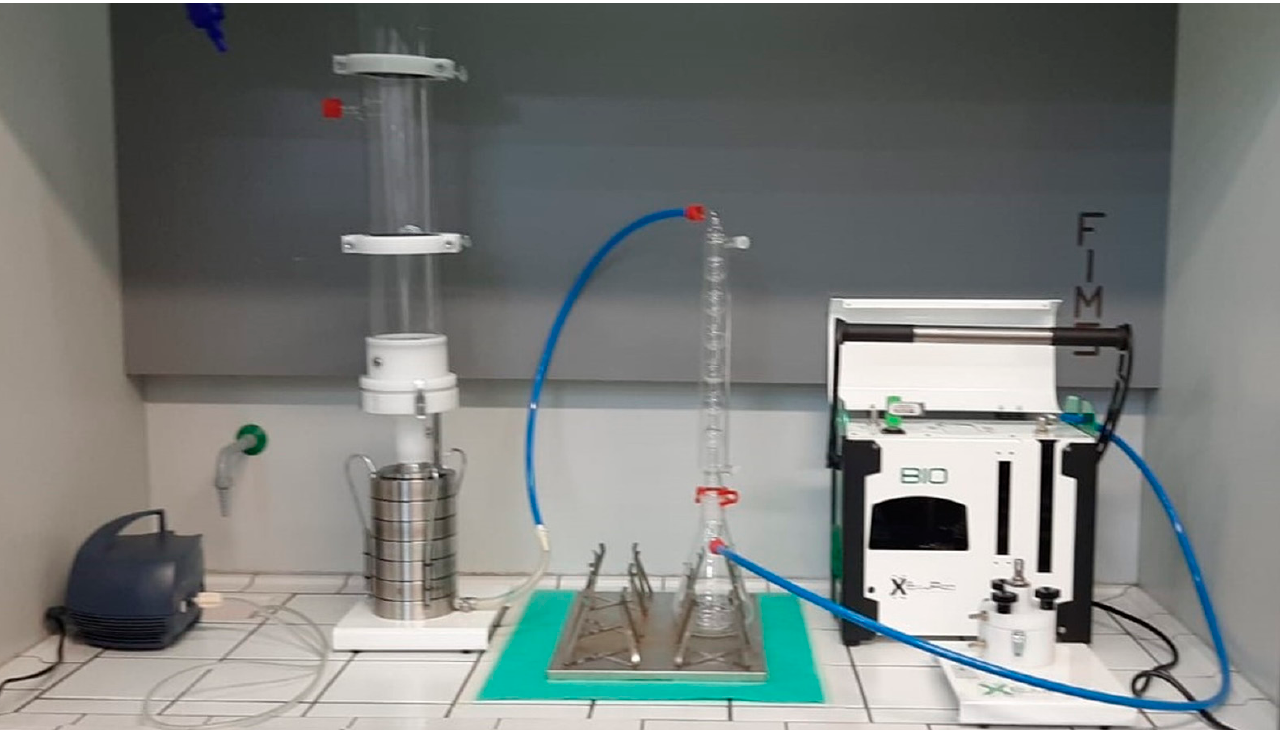
Figure 4. The test system for BFE and DP at Università degli Studi di Cagliari (UNICA). UNITN activated the LASS-TN-Covid-19, an associated laboratory for the assess- ment of personal protective devices, joining staff and structures available at the Depart- ment of Industrial Engineering and at the Public Health Laboratory of the Provincial Heath Trust of Trento Province. The set-up for the measurement of DP was custom-made (Figure 5a), according to specifications reported in the Annex C of EN 14683:2019+AC. The flow cell (a cylinder 25 mm in diameter and 32 mm high, made of two halves, each 16 mm high) was obtained by superimposing several polymethylmethacrylate slabs, laser cut and glued with epoxy resin. The 28 mm disk sample obtained from the mask was positioned between the two halves of the transparent flow chamber that were then pressed together using four screws and bolts. A 25 mm silicone elastomeric annular gasket prevented air leakage and forced the air flow through a sample circular section of 25 mm. The flow rate at 8 L/min was generated by a rotary pump and adjusted by two analog flow meters with control valves, positioned immediately before and after the flow cell.